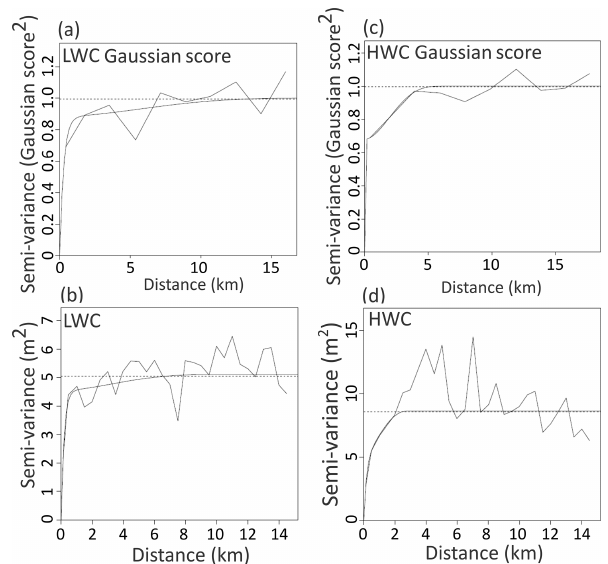
Figure 2. Experimental variogram and fitted variogram model of unaffected UZD data and Gaussian score, for the LWC dataset (a, b) and HWC dataset (c, d) .